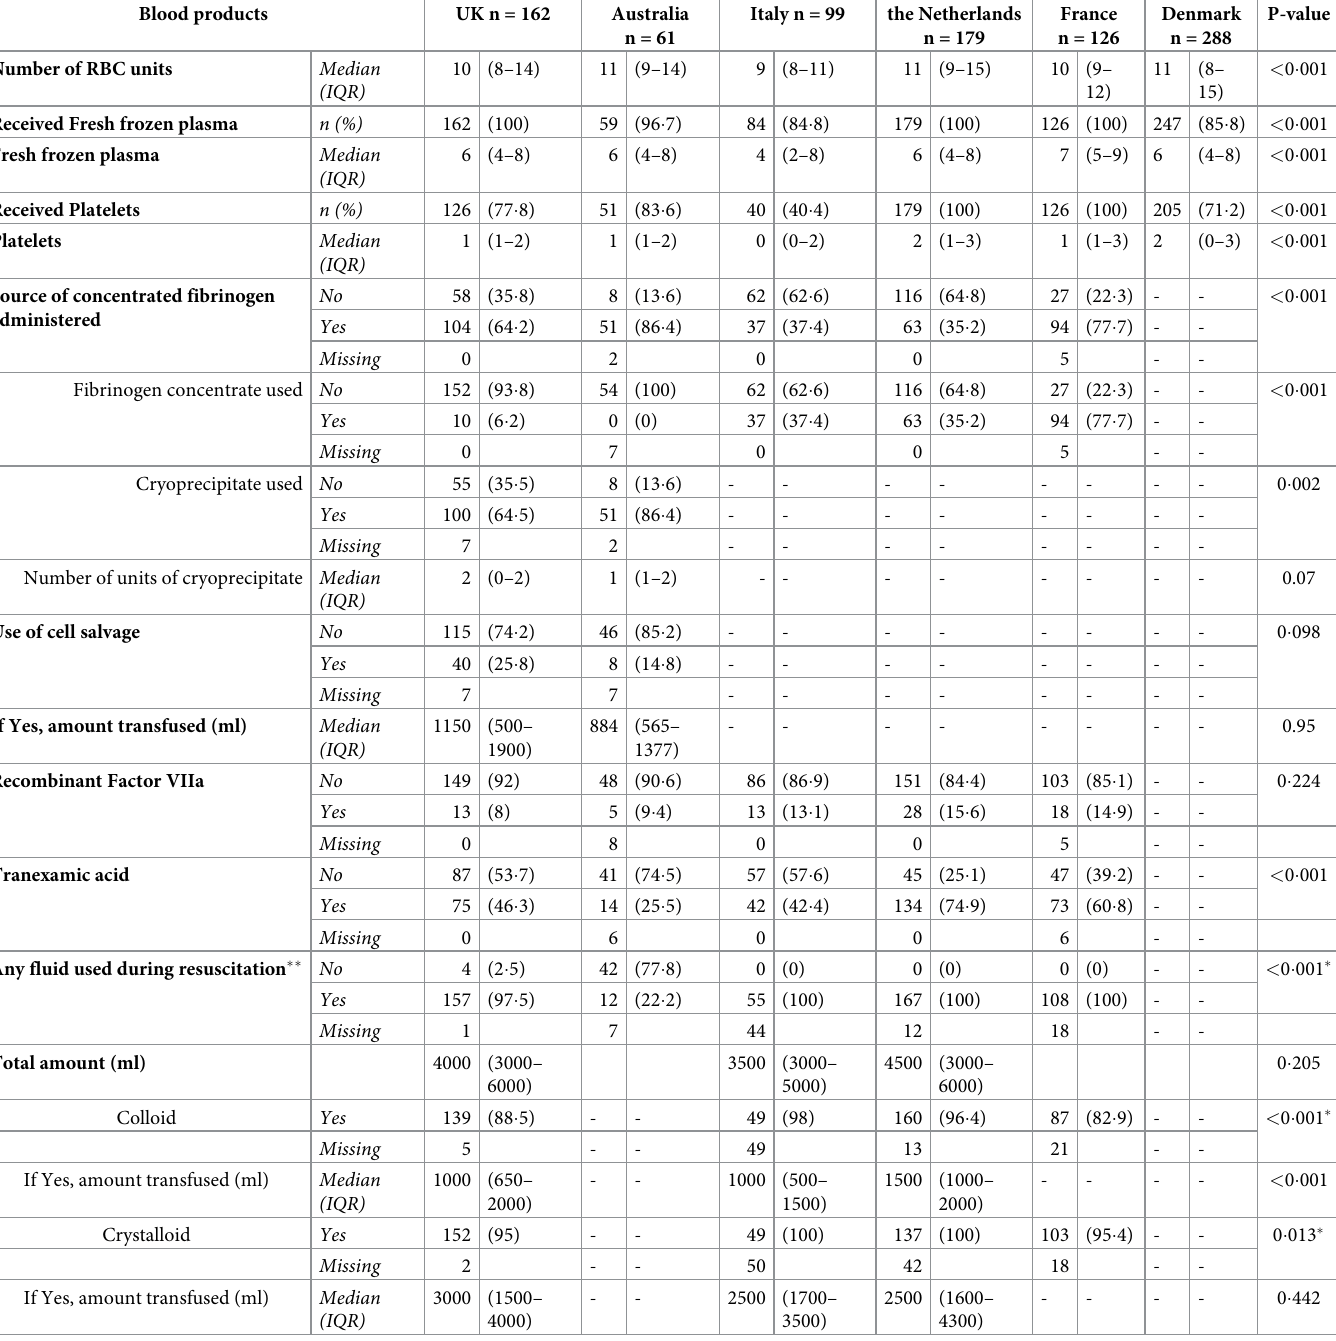
Table 3. Haematological management by